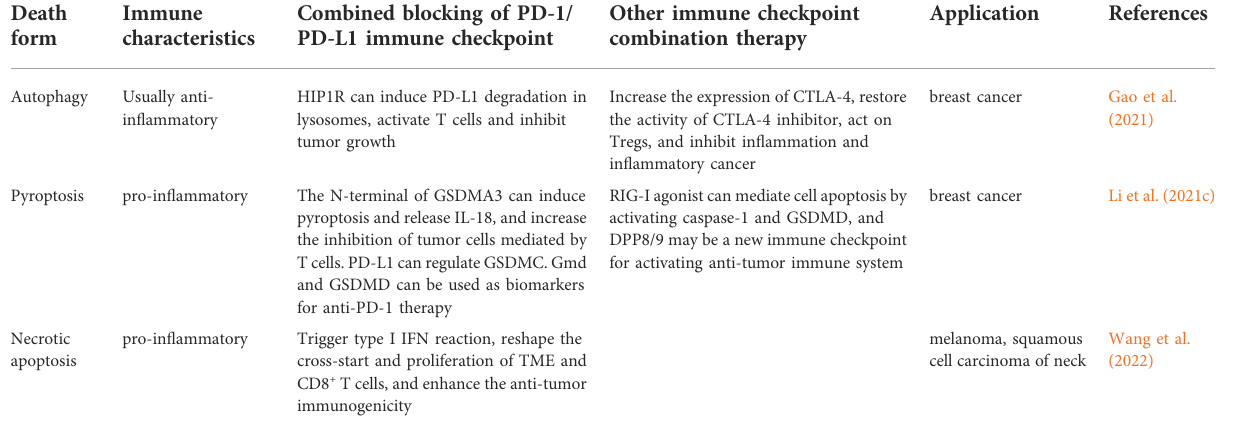
TABLE 3 Comparison of ferroptosis with other forms of cell death in